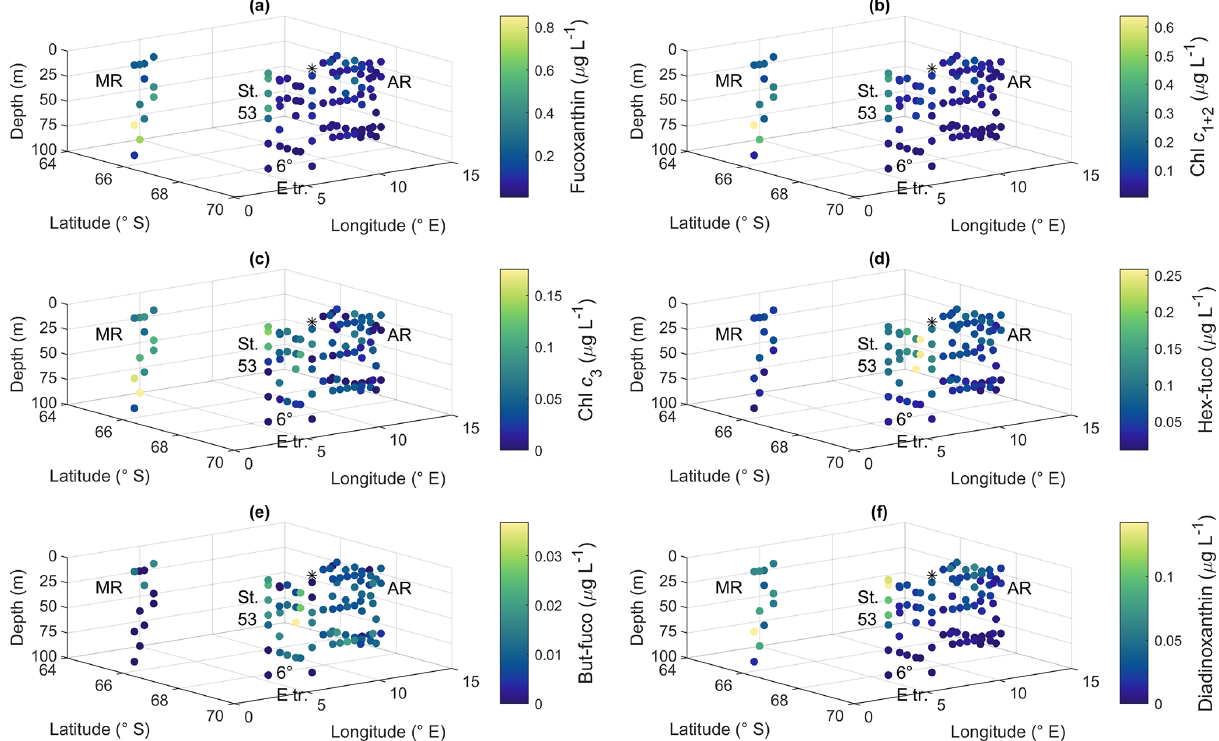
Figure A11. Pigment concentrations of (a) fucoxanthin, (b) Chl c 1 + 2 , (c) Chl c 3 , (d) hex-fuco, (e) but-fuco and (f) diadinoxanthin.